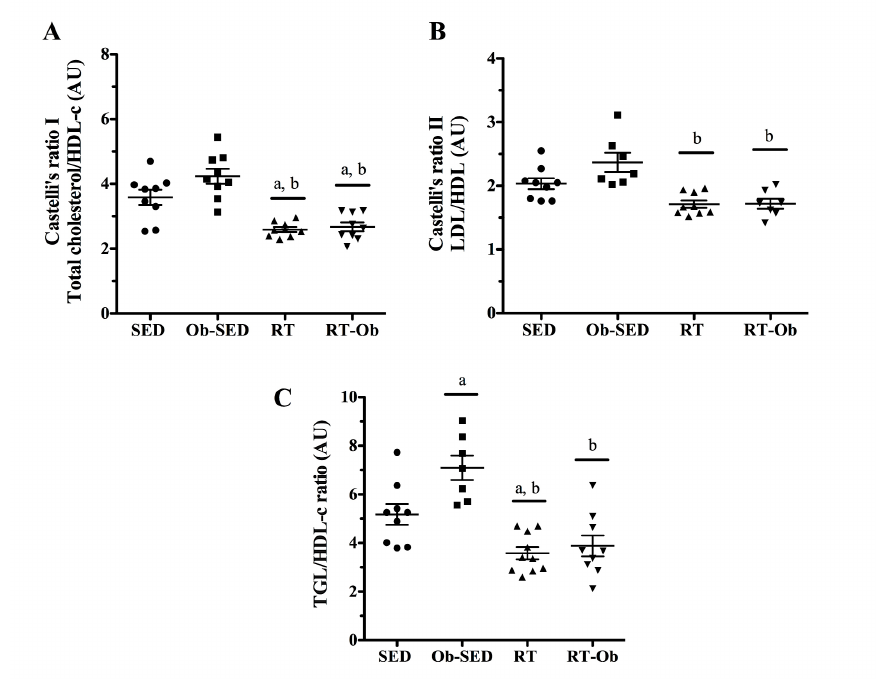
Figure 5 - Effect of high-fat diet and RT on cardio-metabolic parameters. In Panel A- Castelli’s ratio I, Total cholesterol/HDL-c; B- Castelli’s ratio II LDL-c/ HDL-c; and C- LDL-c: Low-density lipoprotein cholesterol; HDL-c: high-density lipoprotein cholesterol. SED, Sedentary group; Ob-SED, Obese sedentary group; RT, resistance training group; and Ob-RT, obese trained